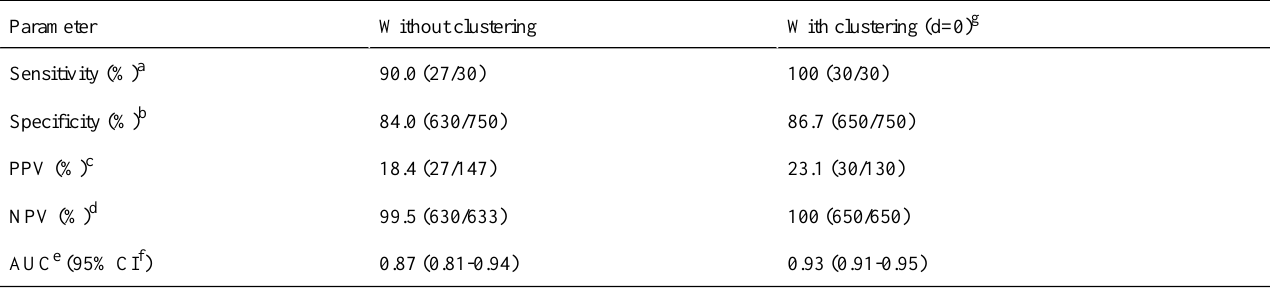
Table 2. Performance in outbreak detection according to germ criterion and a upper control limit defined by 90% confidence interval, with and without clustering.